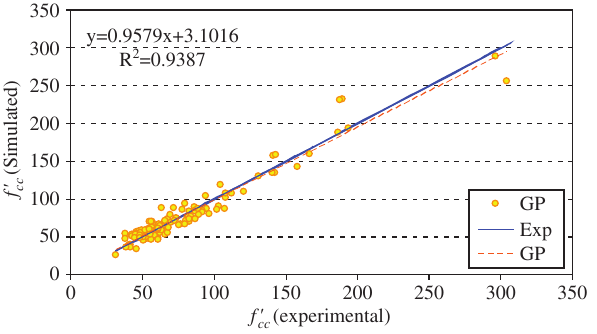
Figure 15 Predictions of the best ANFIS model against experimental data.